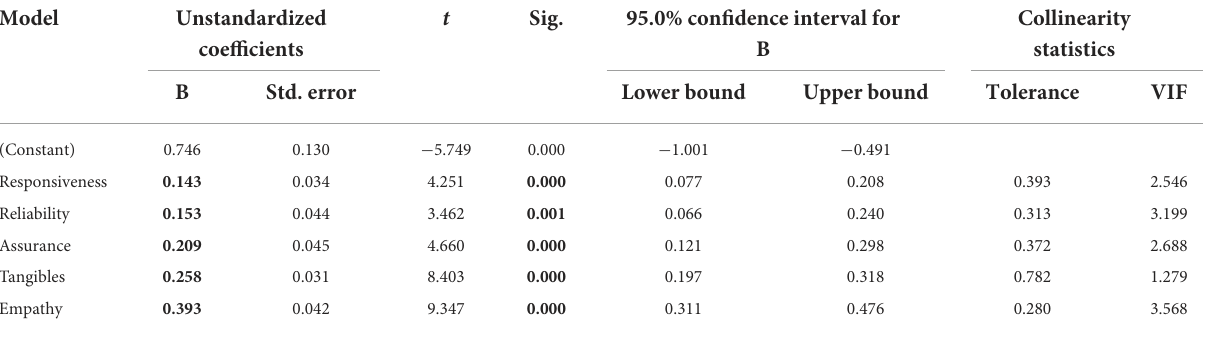
TABLE 11 Analysis of multiple regression “patient satisfaction—quality of service” at public hospitals based on the real perception of the patients.